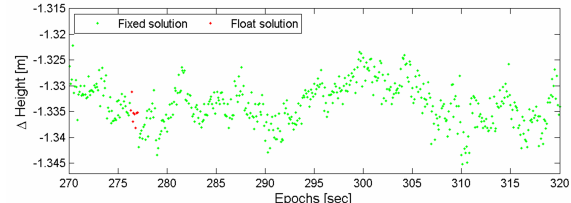
Figure 8: An enlarged view of the marked section of the height time series, which is shown in Figure